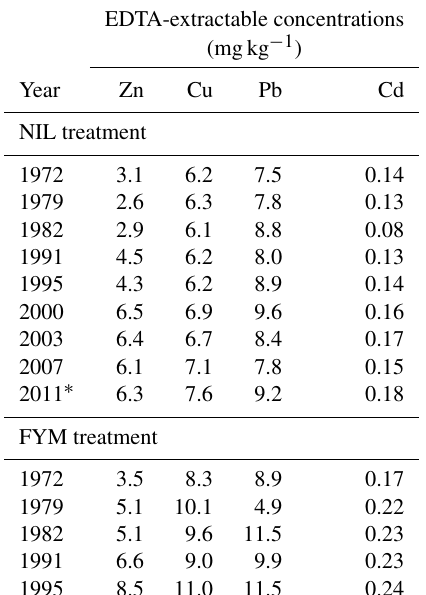
per year . Clearly, the contribution of the apparent weath- ering rate is not negligible relative to other natural